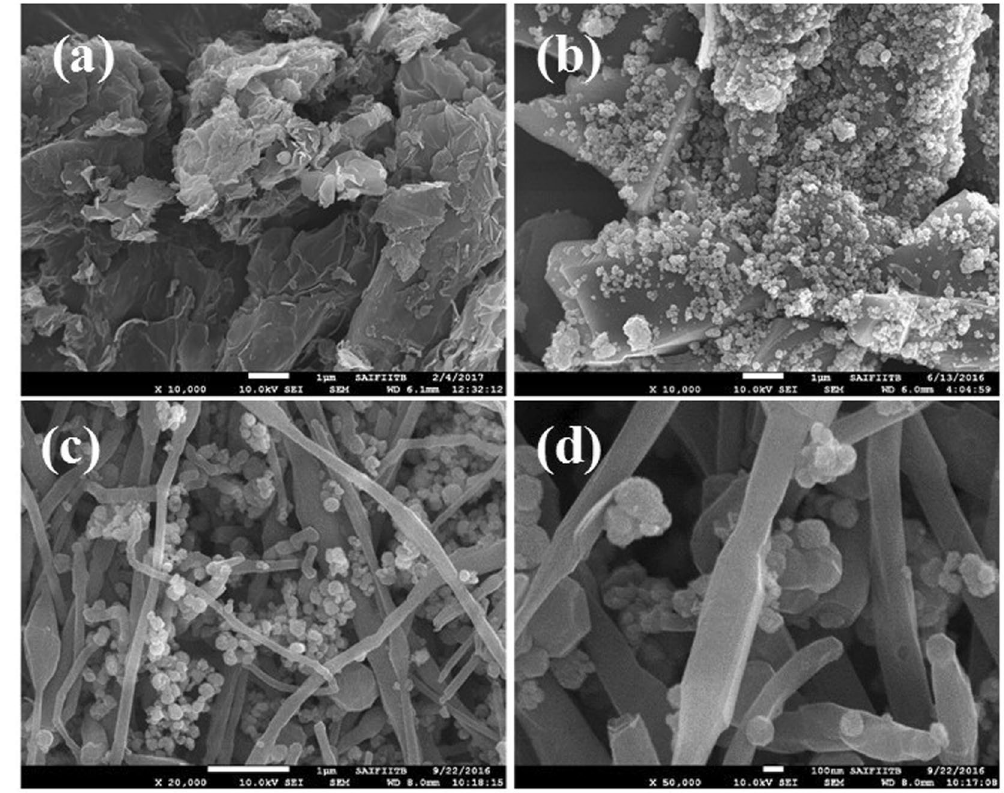
Figure 2. FE-SEM images of ( a ) porous graphene (PG), ( b ) porous graphene - CoFe 2 O 4 (PG-C), ( c – d ) carbon nanofibers - CoFe 2 O 4 (CNF-C) at different